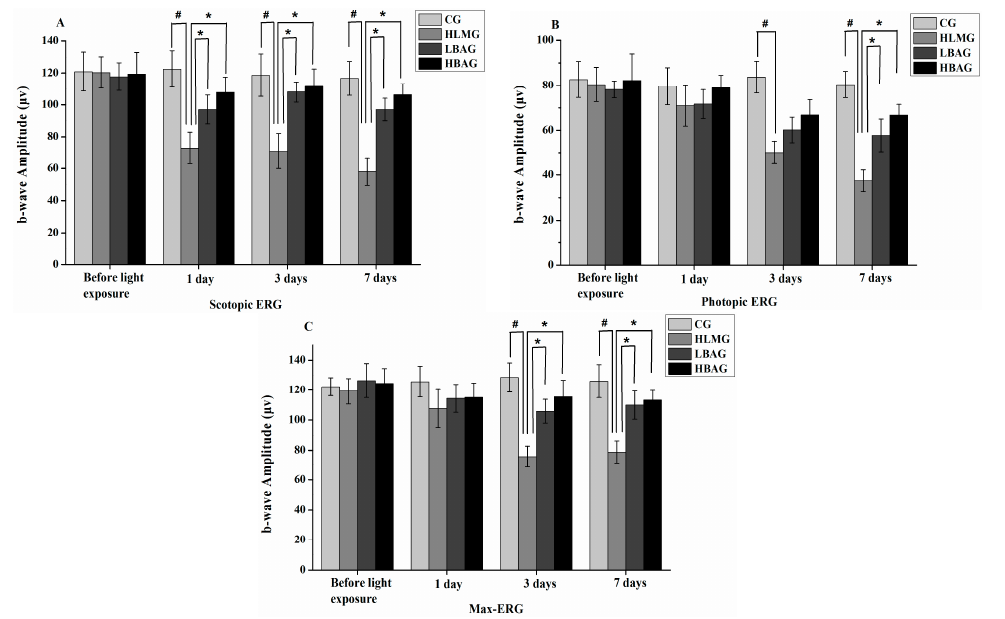
Figure 2. Values for the b-wave amplitudes of ( A ) scotopic; ( B ) photopic; and ( C ) max electroretinograms (ERGs) from retinas in rabbits in the CG, HLMG, LBAG, and HBAG at 1 day before and 1, 3, and 7 days after light exposure. Data are expressed as the mean ± standard deviation ( n = 8). #, * p < 0.05 ( t -test). CG: no light exposure and vehicle administration; HLMG: 18,000 lx light exposure and vehicle administration; LBAG: 18,000 lx light exposure and administration of low dosage of